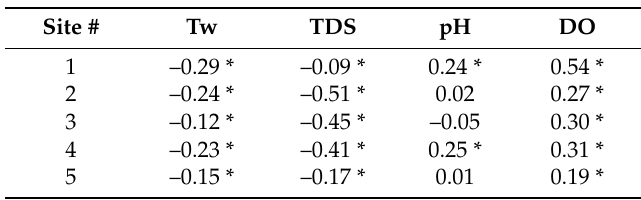
Table 5. Spearman correlation coefficients for relationships between stream physiochemical parameters and daily average streamflow at each gauging site ( n = 5) during study period (October 2010–May 2014) in Hinkson Creek Watershed, MO,